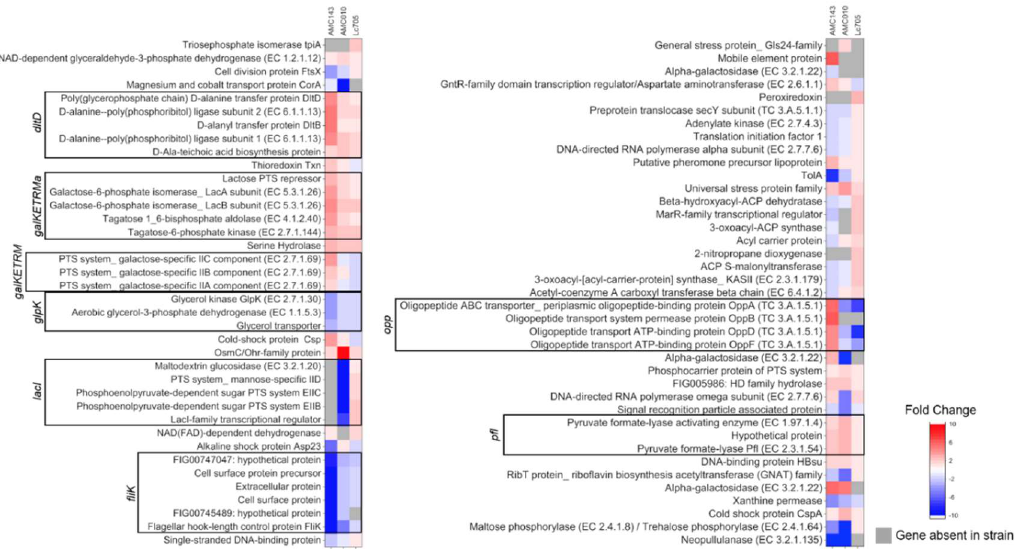
Figure 4. Transcriptomics analysis. Heat maps for AMC143, AMC010, and Lc705 were generated from sequencing reads mapped to their respective genome sequence and plotted to show fold changes between cultures in glucose compared to GOS. Boxed genes represent potential operons, and grayed genes represent genes absent in the associated strain. Three biological replicates were included in each experiment.